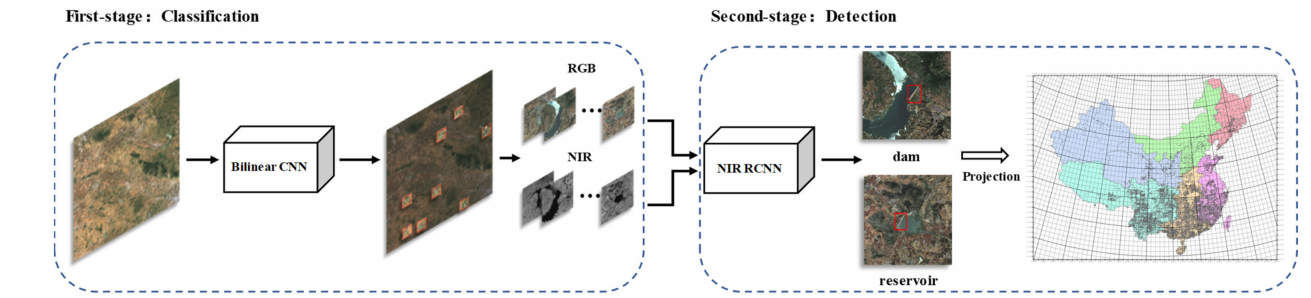
Figure 6. An illustration of the two stage CNN framework with first stage classification network and second-stage detection network.